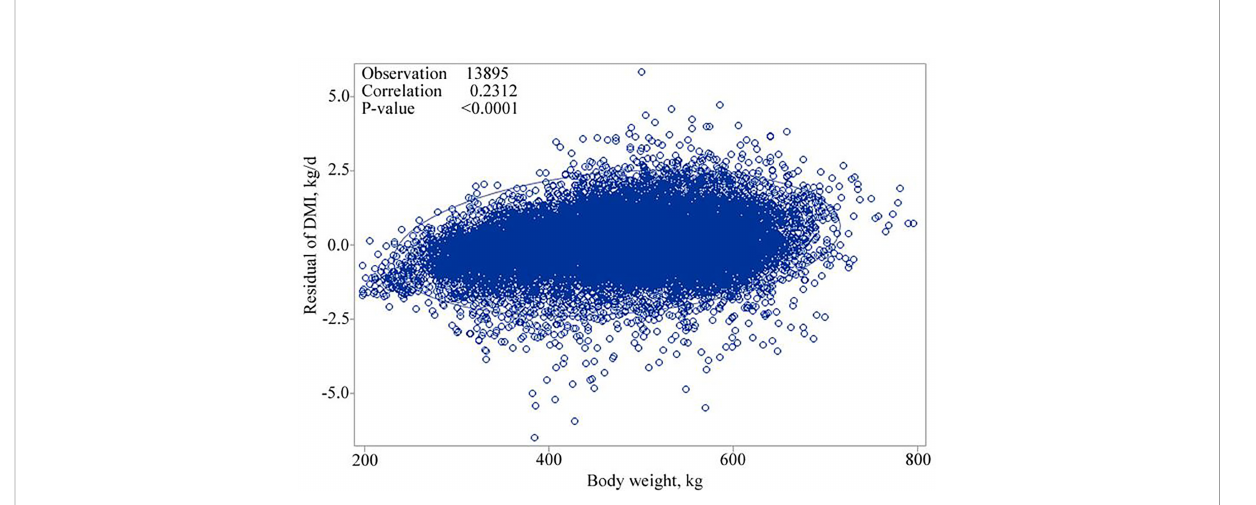
FIGURE 1 Scatter plot showing the relationship of residuals of dry matter intake (DMI) against body weight,